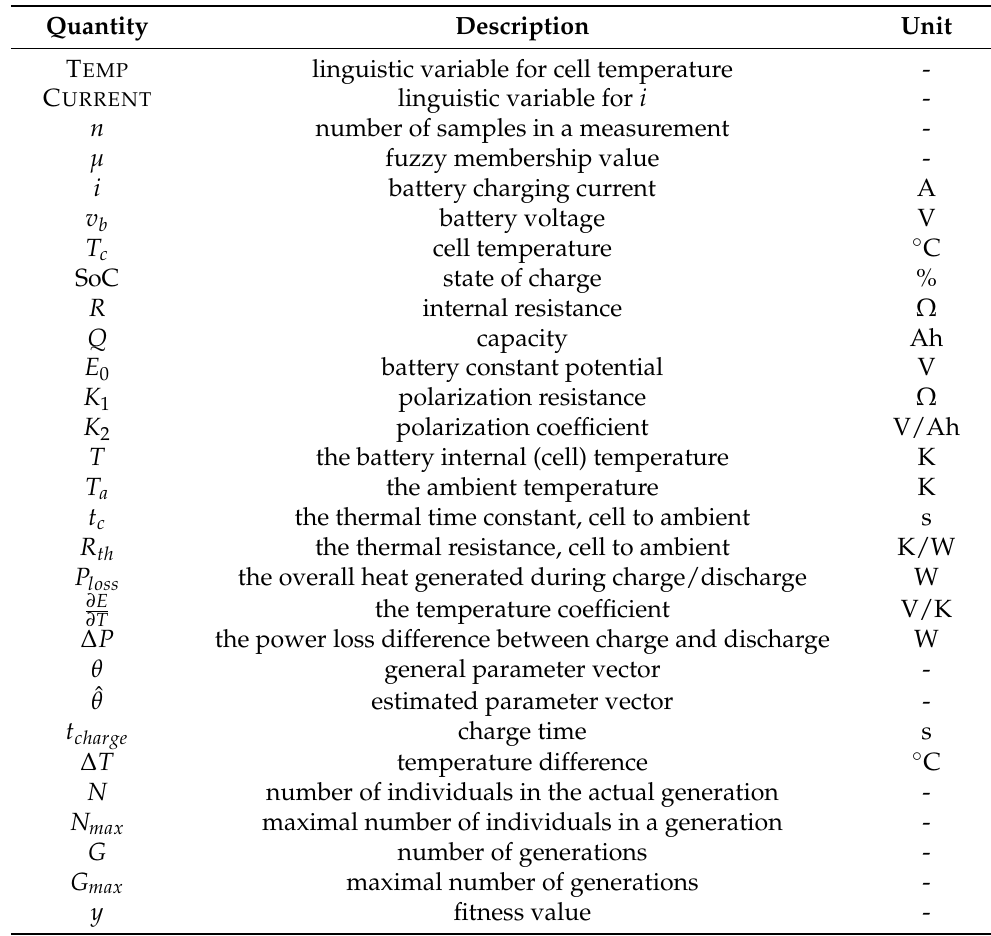
Table A1. List of